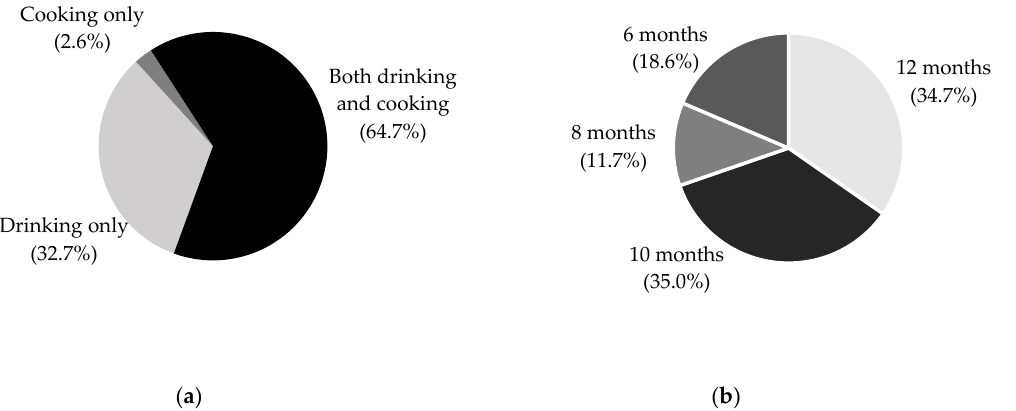
Figure 3. ( a ) The typical use of rainwater in the study area; ( b ) a distribution of the time rainwater is available for domestic use in the study area. The values in the parenthesis indicate the proportion of households.